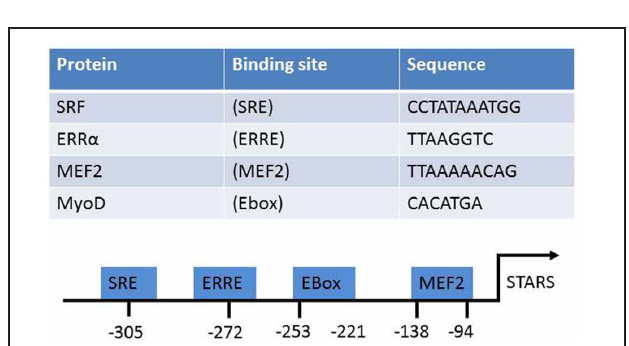
FIGURE 2 | The known transcriptional activators of STARS, their target sequences, and location on the STARS promoter.